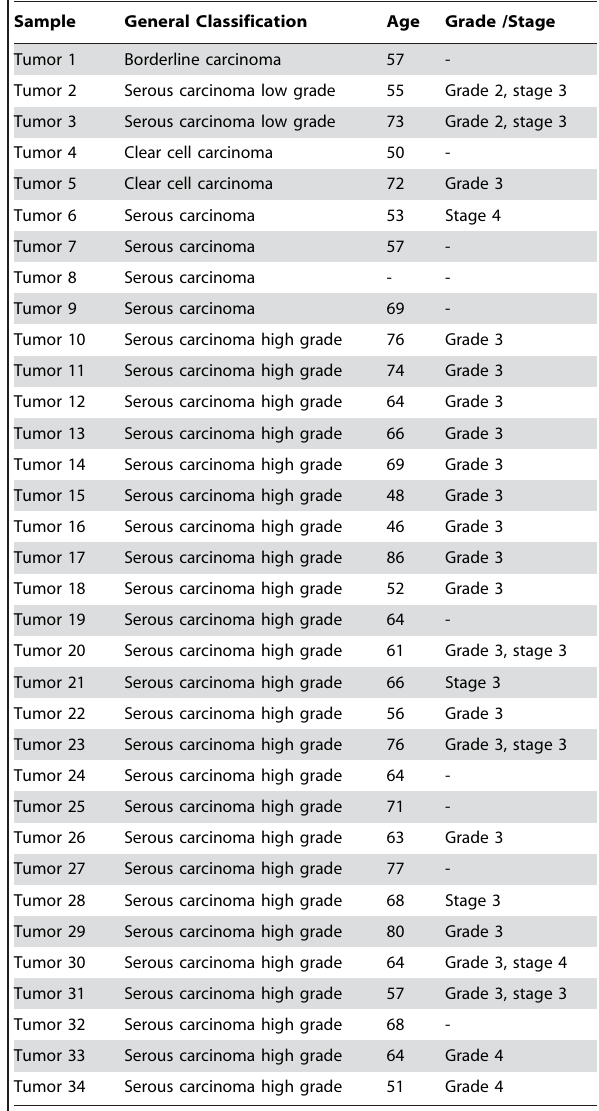
Table 1. Patient